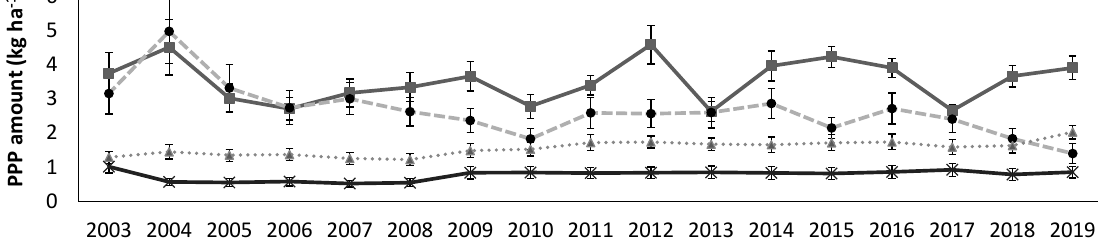
Fig.1. Total active ingredient usage of PPP (kg ha -1 ) on potato, swede, carrot and pea crops in